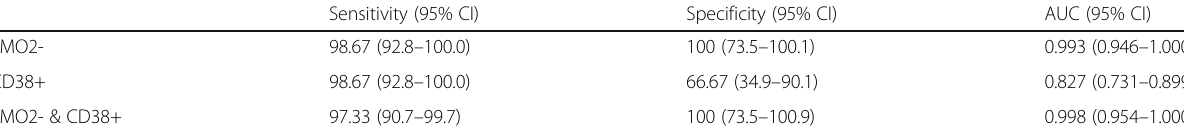
Table 3 Sensitivity and specificity of immunostaining combinations